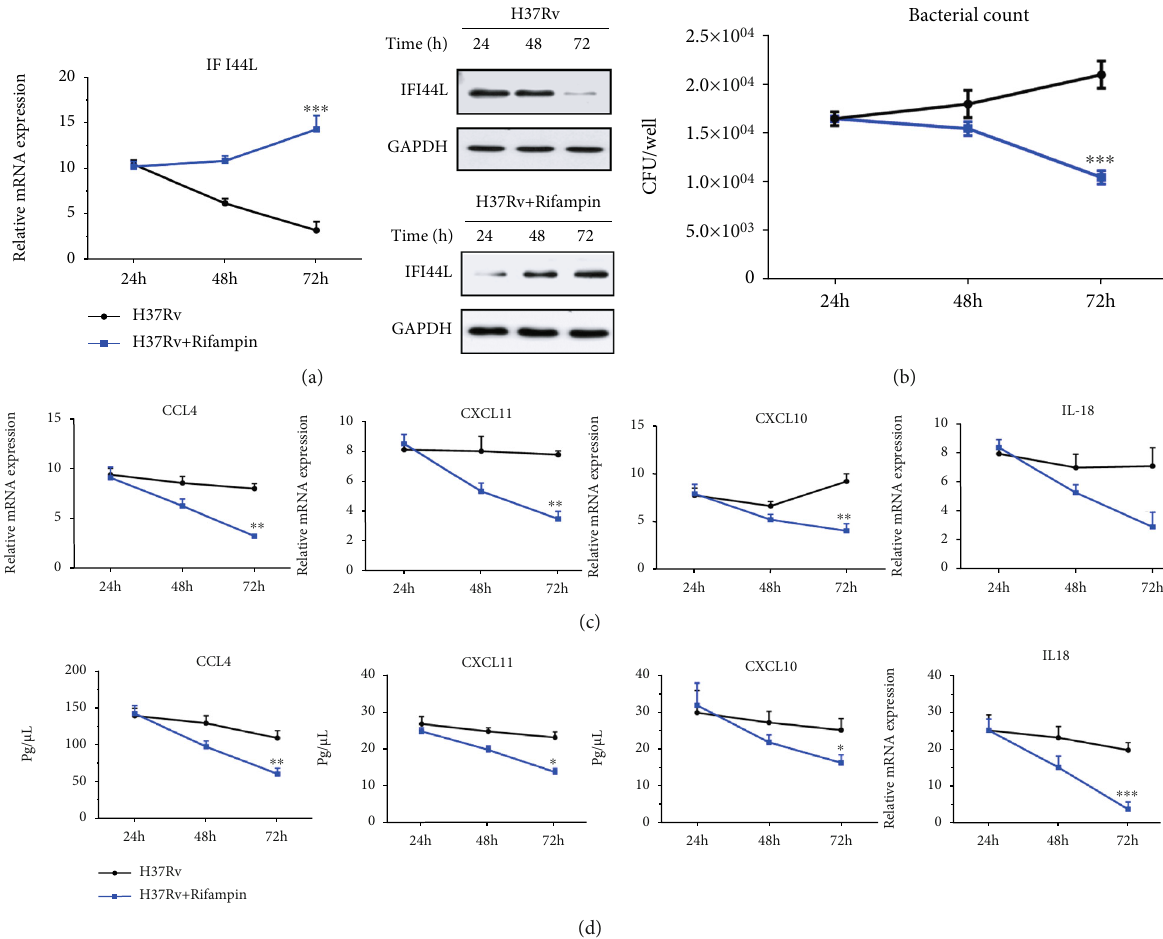
Figure 5: Analysis of in fl ammatory gene expression after rifampicin treatment in M. tuberculosis H37Rv-infected macrophages. (a, b) Increase in IFI44L expression in M. tuberculosis H37Rv-infected macrophages after 24 h of rifampicin therapy and signi fi cant increase after 72 h of rifampicin therapy in comparison with levels at 24 h. Intracellular survival of M. tuberculosis was restricted at 72h, as shown by CFU counting assays. (c, d) CCL4, CXCL10, CXCL11, and IL18 expressions determined by qPCR and ELISA at 24, 48, and 72h. Values are presented as levels relative to β -actin and GAPDH. ∗∗ P < 0 : 01 ; ∗∗∗ P < 0 : 001